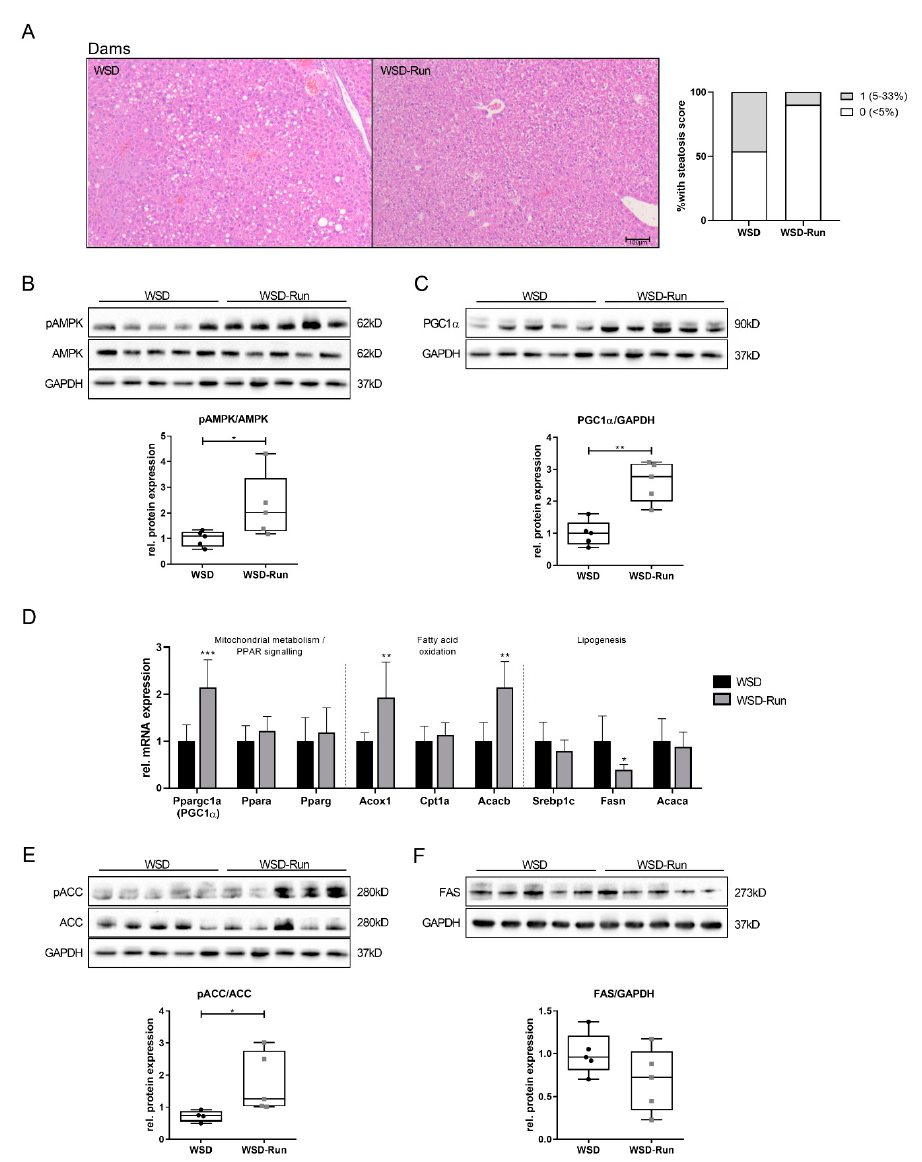
Figure 2. Maternal exercise before and during pregnancy prevents obese dams from WSD-induced hepatic steatosis. ( A ) Histological hepatic steatosis in dams at the end of lactation (P21) by H&E staining. Magnification: 20×. Percentage of steatosis, scored as 0 (<5%) or 1 (5–33%) percentage of hepatocytes containing lipid droplets (WSD group (n = 13), WSD-Run group (n = 9)). ( B – C ) Assessment of key hepatic energy regulators using immunoblots. ( B ) pAMPK/AMPK protein expression. ( C ) PGC1 α protein expression. ( D ) Assessment of regulators of hepatic mitochondrial metabolism ( Ppargc1a (Pgc1 α ), Ppara , Pparg ), hepatic fatty acid oxidation ( Acox1 , Cpt1a , Acacb ), and hepatic lipogenesis ( Srebp1c , Fasn , Acaca ) by qPCR (WSD group (n = 5), WSD-Run (n = 10)). ( E – F ) Assessment of key enzymes of hepatic lipogenesis using immunoblots. ( E ) pACC/ACC protein expression. ( F ) FAS protein expression. Representative immunoblots are presented above the re- spective graph. Immunoblots: WSD group (n = 5), WSD-group (n = 5). GAPDH served as loading control. Data are pre- sented as mean ± standard deviation; * p < 0.05, ** p < 0.01, *** p < 0.001. ACC, acetyl-CoA carboxylase; Acac, gene encoding